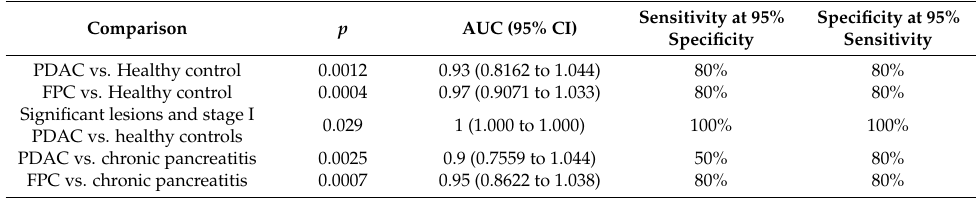
Table 4. Performance of the serum biomarker panel miR-196b + TIMP1 + LCN2.